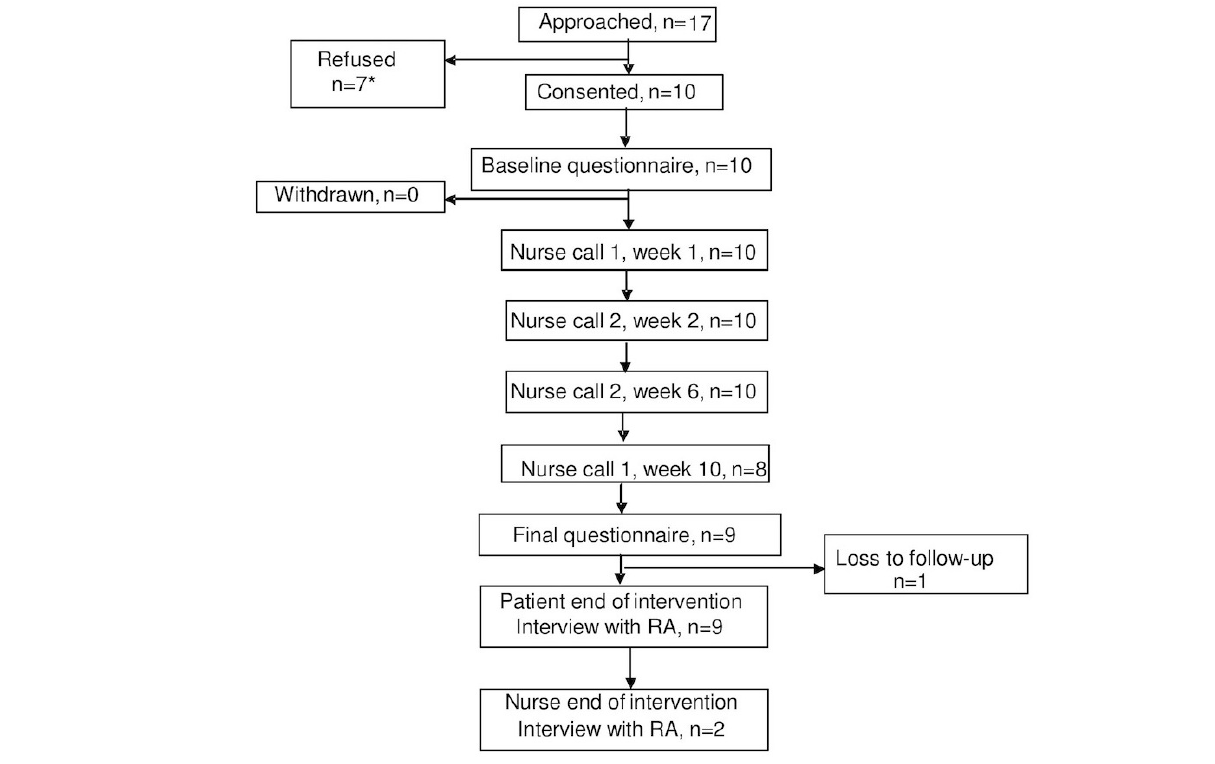
Figure 3. CONSORT flowchart of participants completing each intervention component and data collection point (RA refers to research